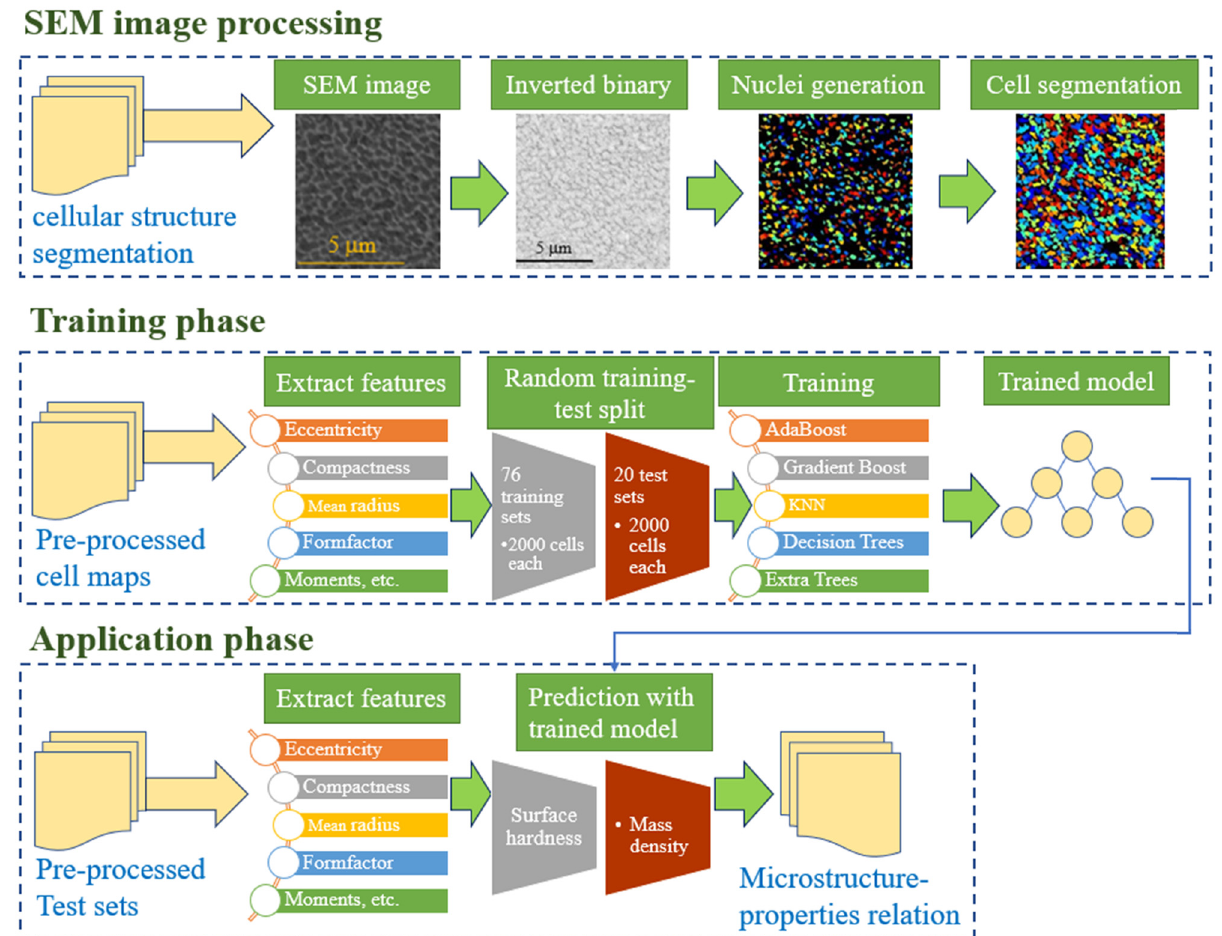
Figure 4: Schematic of the proposed processing framework pipeline for LBPF produced AlSi10Mg nanocomposites microstructure – pro - perties